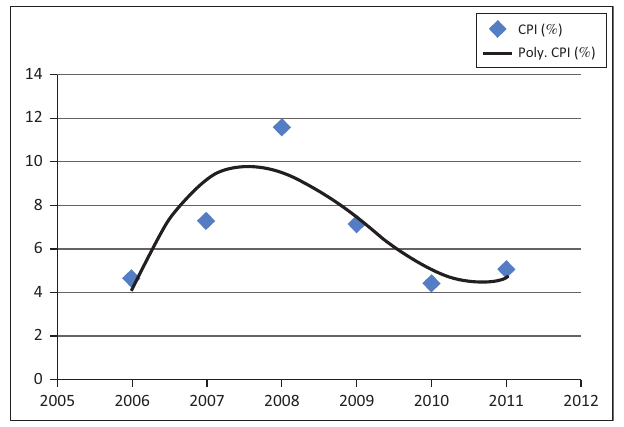
CPI, consumer price index. FIGURE 7: Consumer price index ( % ) TABLE 7: Cost to company mean, median, standard deviation. Cost to company mean